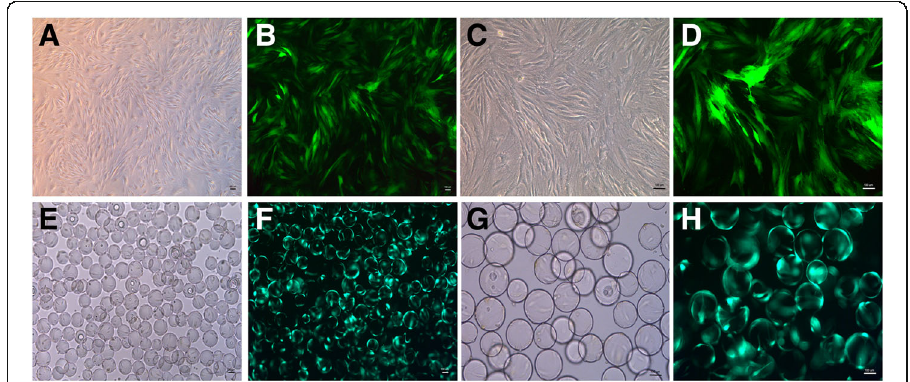
Fig. 1 BMSC morphology. ( a and c ) BMSC morphology observed via inverted microscope in the 2D environment; ( b and d ) BMSC morphology observed via fluorescence microscopy after viral transfection; ( e and g ) BMSCs adhere to the surface of the Cytodex 3 microcarriers observed via an inverted microscope; ( f and h ) BMSCs adhere to the surface of the microcarriers via fluorescence microscopy after viral transfection. (Bar = 100 um)